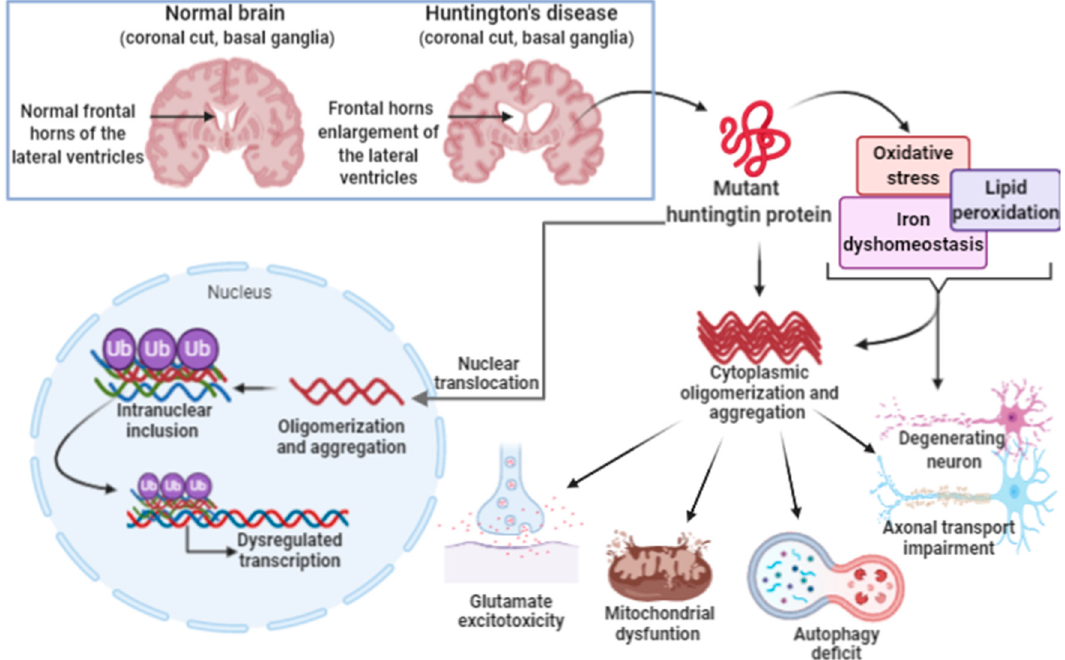
Figure 6. Huntington’s disease. Huntington’s disease is caused by the repetition of autosomal dominant CAG trinucleotide in the Huntingtin gene (HTT gene) on chromosome 4, giving rise to the mutant huntingtin protein. The mutated protein translocates to the nucleus and remains in the cytoplasm. In the nucleus, association, oligomerization and aggregation with other proteins occurs, leading to the formation of inclusions. Protein inclusions disrupt the transcriptional process in nerve tissue cells. In the cytoplasm, the oligomerization, aggregation and precipitation of the huntingtin protein occurs. This process alters the metabolism and both intra- and extra-cellular signaling pathways. The increase in oxidative stress, lipid peroxidation and iron dyshomeostasis contribute to the aggregation and oligomerization of huntingtin protein with other cytoplasmic proteins. Aberrant protein aggregation increases the excitotoxicity of glutamate. Mitochondrial dysfunction changes autophagy mechanisms, and transport in the neuronal axon, leading to nerve cell